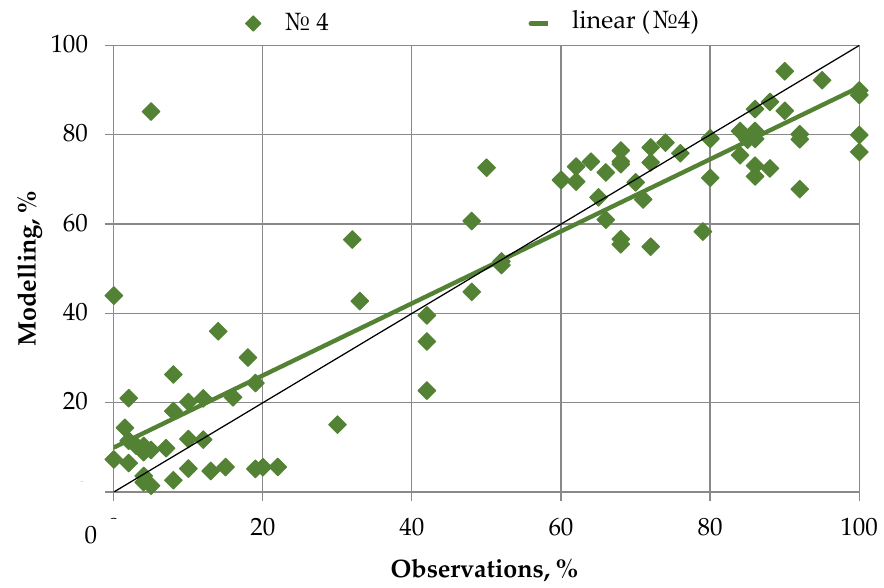
Figure 5. Scatter of modeling residuals (M) in relation to experimental data (O) for well type No. 2.